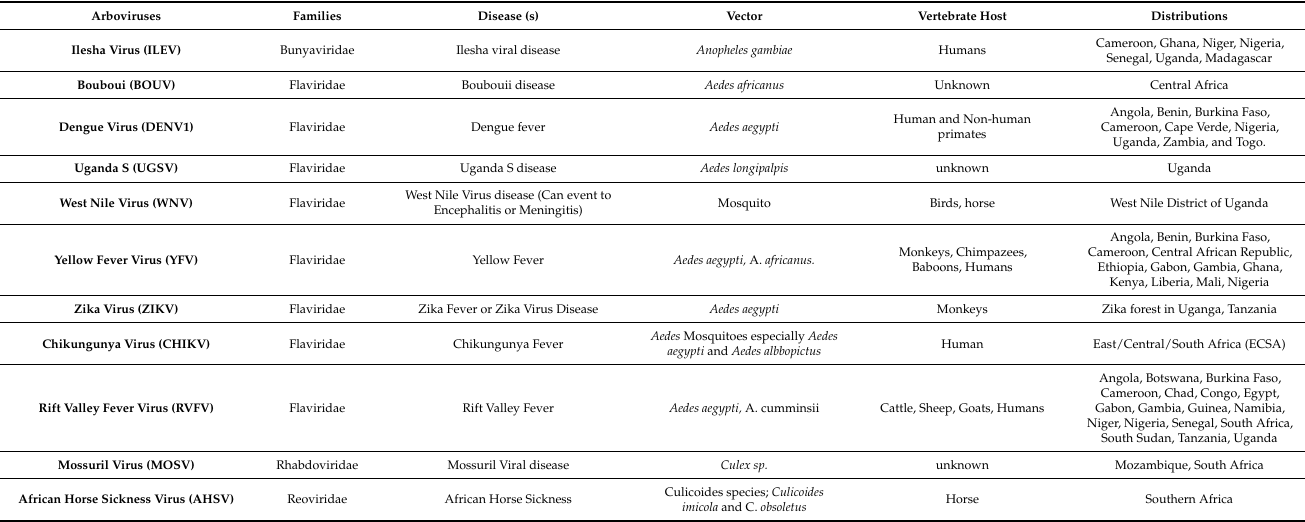
Table 1. Emerging Arboviruses in Africa and their Arthropod Vectors